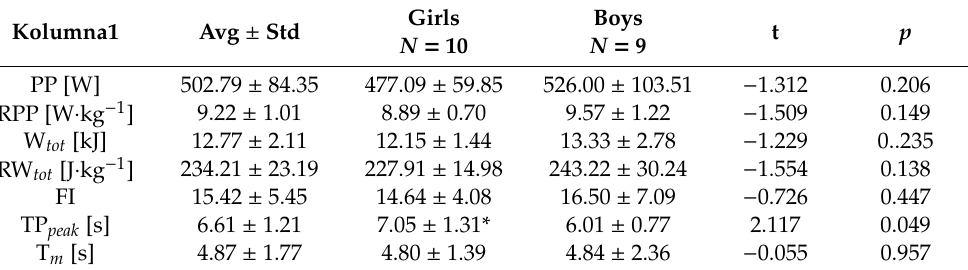
Table 2. Results of Wingate test (mean ± SD, t, p